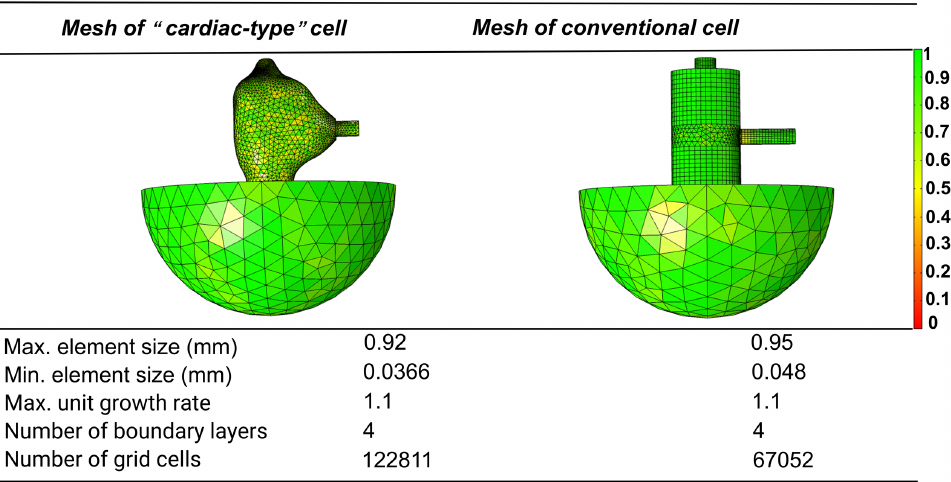
Figure 4. The properties of the two cell meshes.